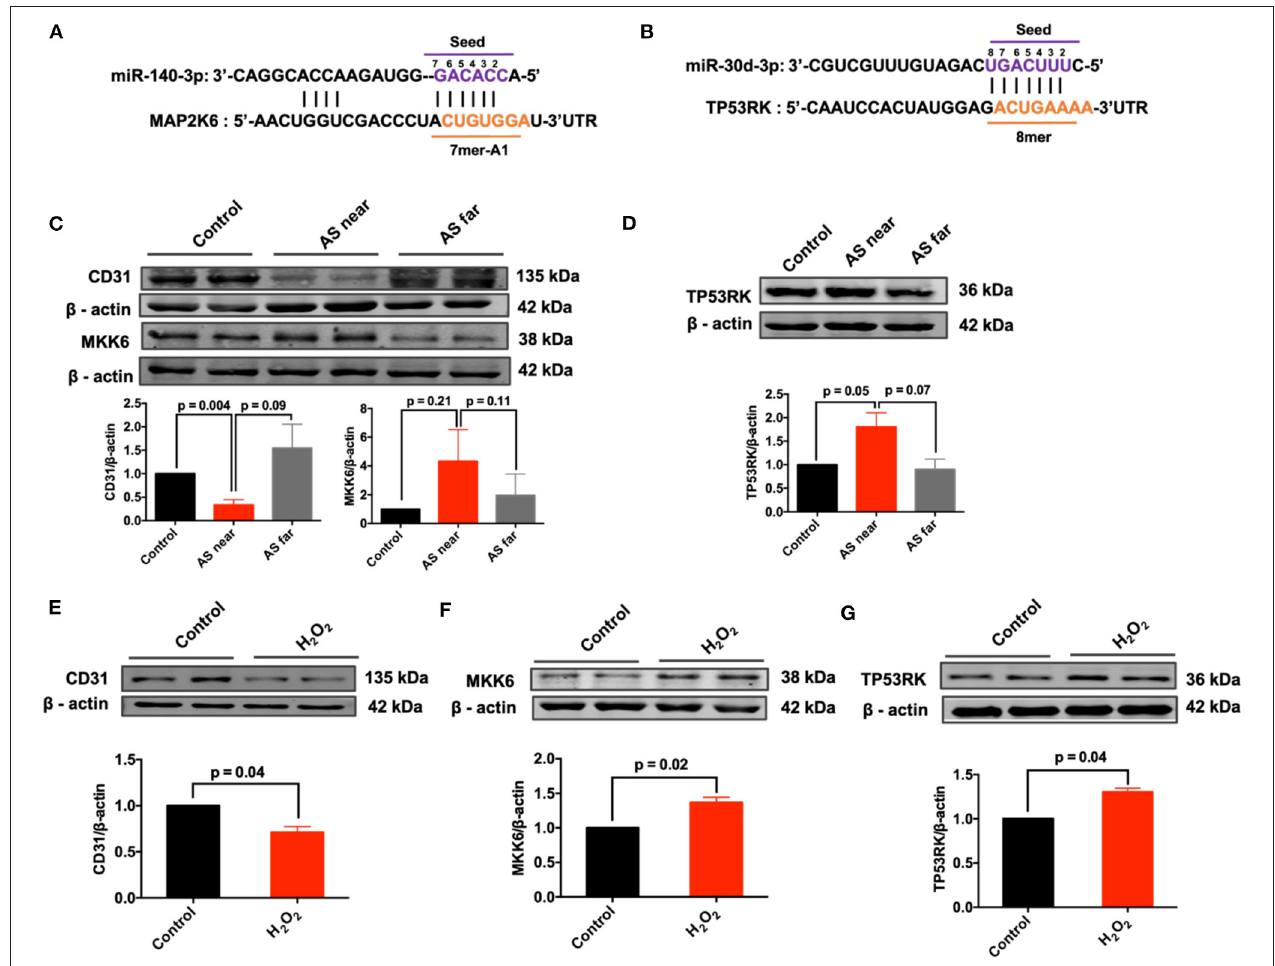
FIGURE 6 | Expression of predicted complementary mRNAs in AS aortas and H 2 O 2 -treated MAECs. (A) The binding sites and 2D structure of miR-140-3p with MAP2K6; (B) The binding sites and 2D structure of miR-30d-3p with TP53RK; (C) Expression of CD31 and MKK6 in control, AS near and AS far aortas, n = 3; (D) Expression of TP53RK in control, AS near and AS far aortas, n = 3; (E–G) Expression of CD31, MKK6 and TP53RK in H 2 O 2 -treated MAECs, n =